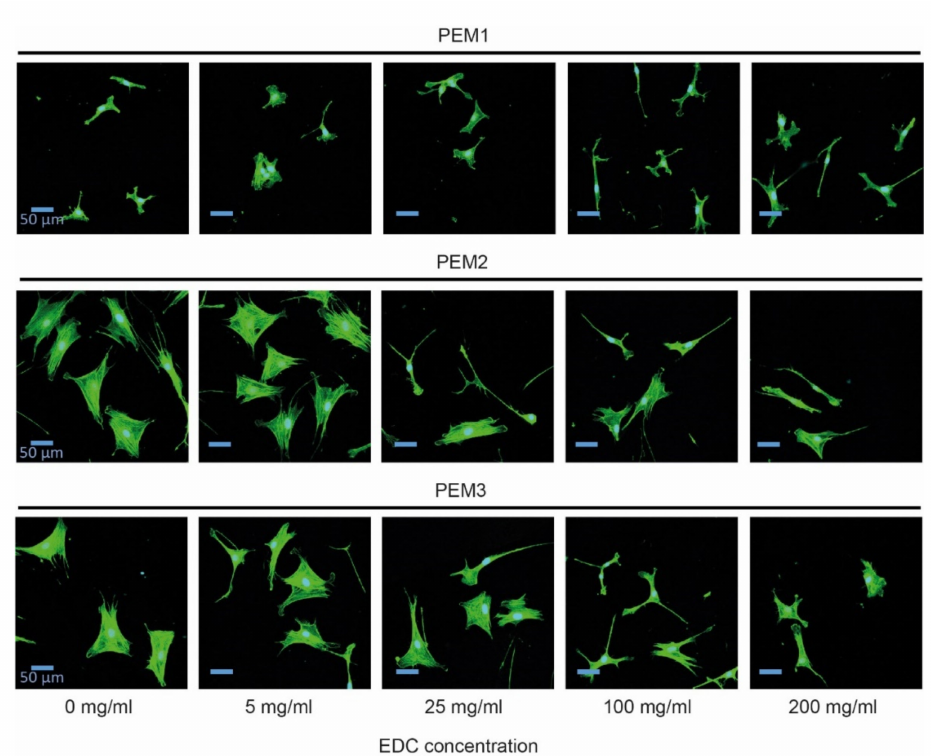
Figure 9. Fluorescence microscope images from MC3T3 cells for analysis of spreading on different PEM films. The experiment was conducted without addition of EDTA to the medium (Scale bar = 50 µ m).